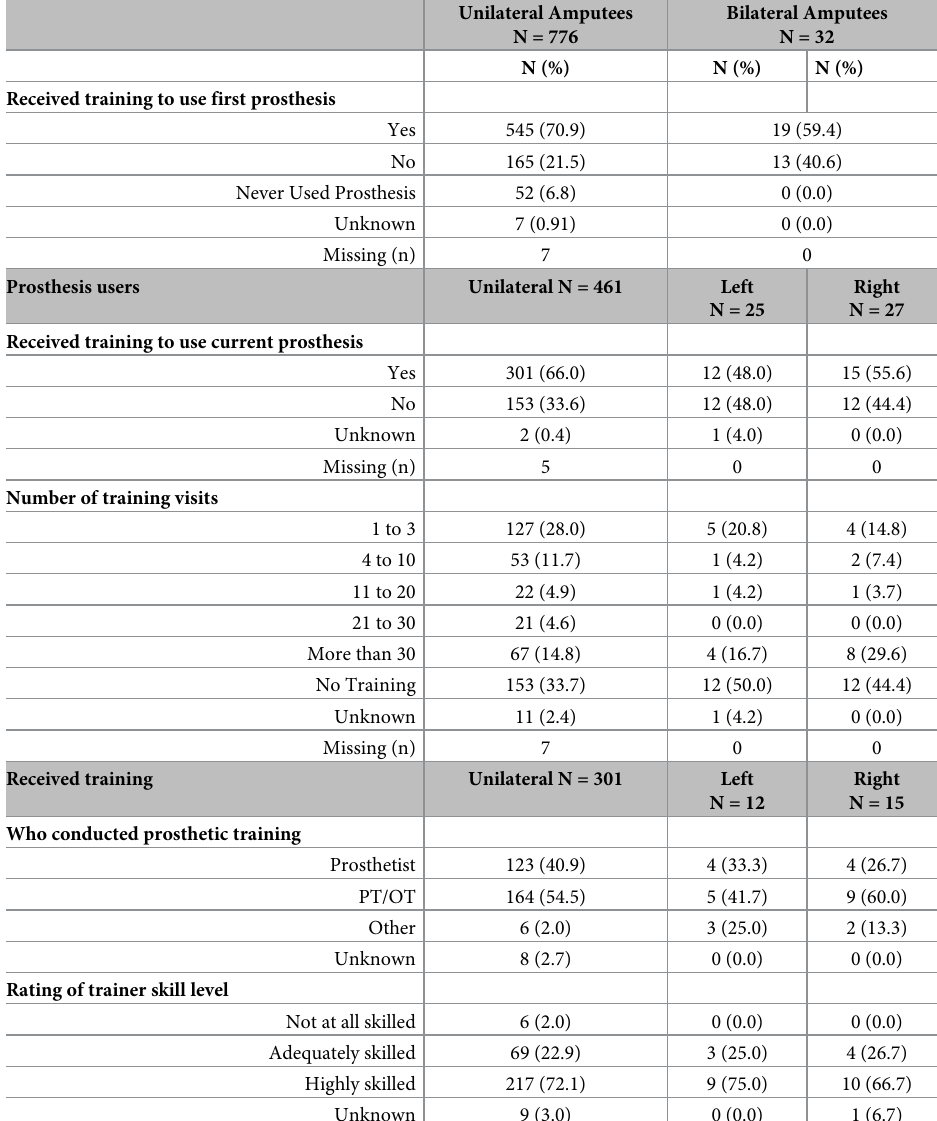
Table 4. Prosthesis